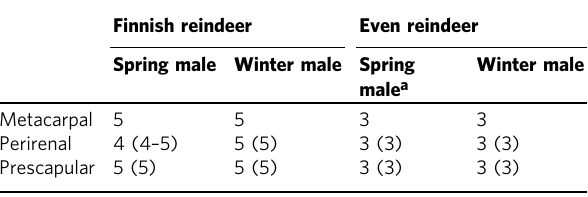
Table 3 Summary of adipose tissue samples used for RNA-seq and physiological studies (the latter in brackets). Finnish